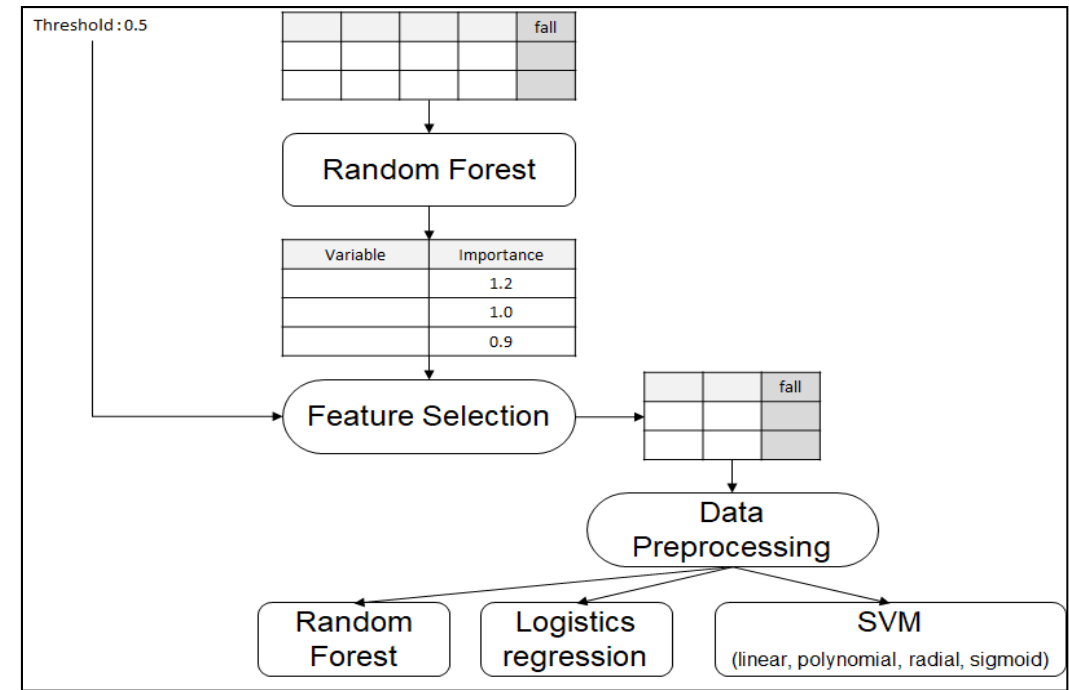
Figure 1. Process of data analysis.